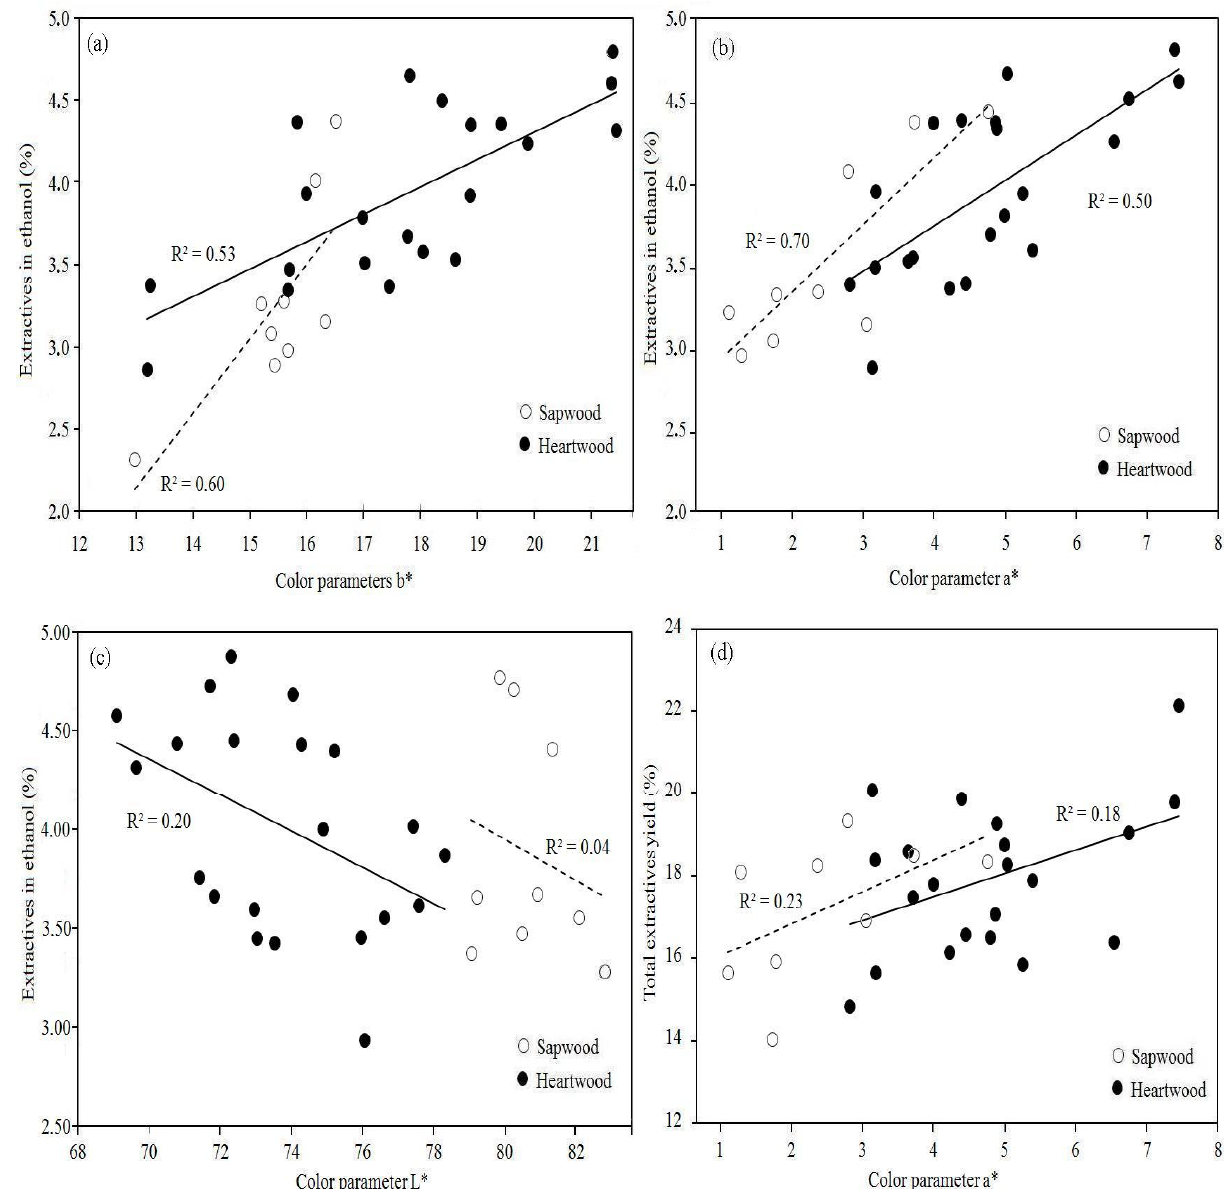
Figure 1. Relationship between extractives in ethanol and the b* and a* color parameters in sapwood and heartwood of Vochysia guatemalensis